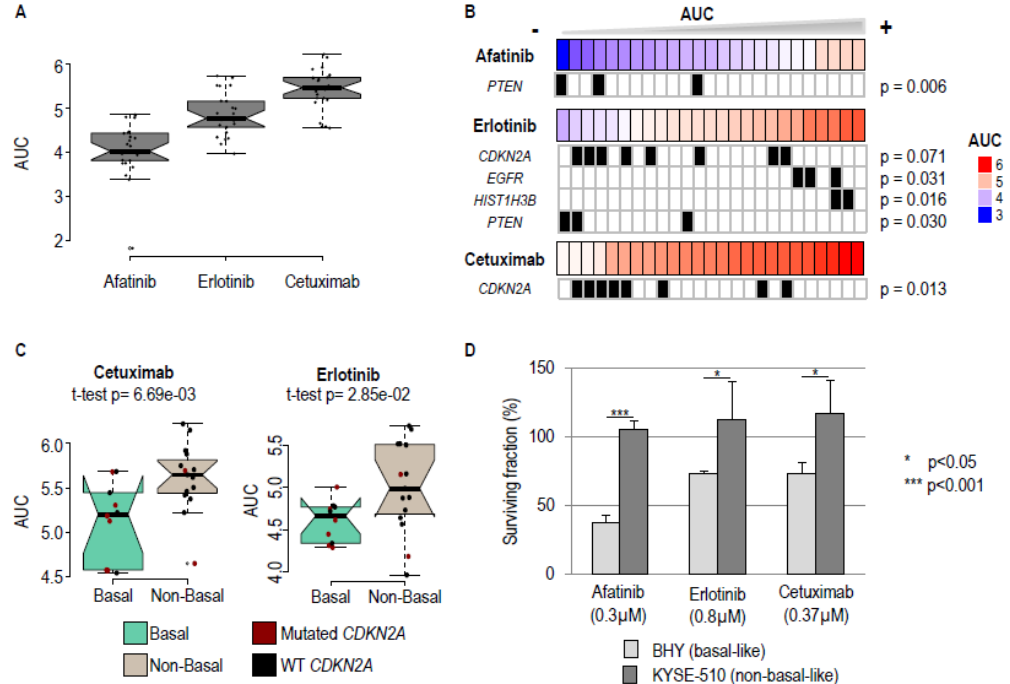
Figure 2. Basal-like HNSCC cells are sensitive to epidermal growth factor receptor (EGFR) blockade. ( A ) Boxplot of the AUC for the 25 HNSCC cell lines treated with the three anti-EGFR drugs (Afatinib, Erlotinib, and Cetuximab). ( B ) Representation of the clinically relevant mutations association with response to Afatinib, Erlotinib, and Cetuximab. For each drug, cell lines are ordered by increasing AUC. p -values correspond to moderate t -test p values, comparing AUC between mutated and wild type (WT) cell lines. ( C ) Boxplot representation of the AUC obtained after Cetuximab and Erlotinib treatment of basal and non-basal HNSCC cell lines. The AUC were found to be significantly lower ( t -test p -values are shown) in basal-like cells. ( D ) Analysis of the clonogenic survival of basal BHY and non-basal KYSE-510 cells upon treatment with Afatinib, Erlotinib, and Cetuximab. BHY cells display a significantly higher sensitivity to EGFR blockade. Mean survival fractions and standard errors from three independent experiments are